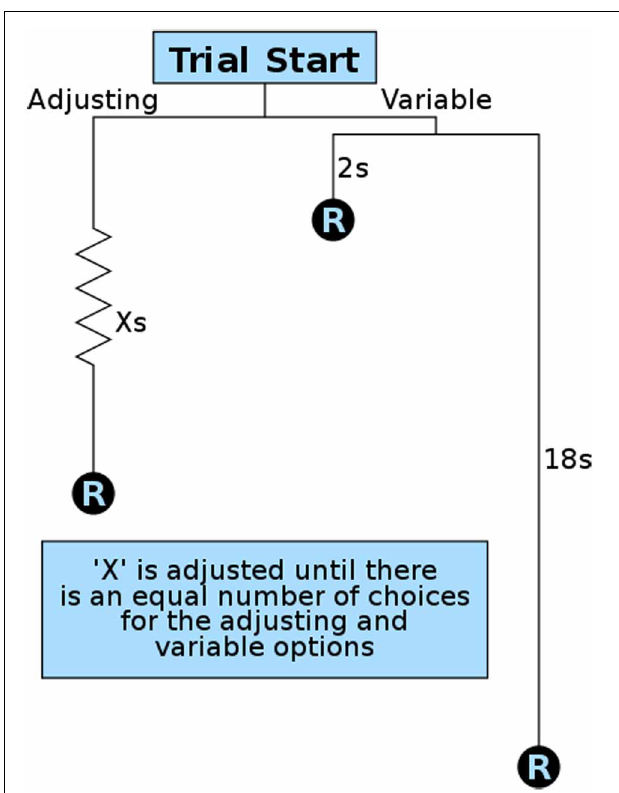
FIGURE 3 | Overview of a single impulsive choice trial. Each free choice trial in the operant test presents the subject with a choice for a stable/adjusting delay reward (R) and a variable delay reward. The variable delay is set randomly per trial to 2 or 18s. The adjusting delay (X) is adjusted after 21 free trials based on a subject’s preference: 12 or more choices of the variable option result in a decrease in the stable delay; 9 or fewer choices of the variable option result in an increase in the stable delay. The amount the adjusting delay is reduced from the initial value of 10s is used as an animal’s delay discounting